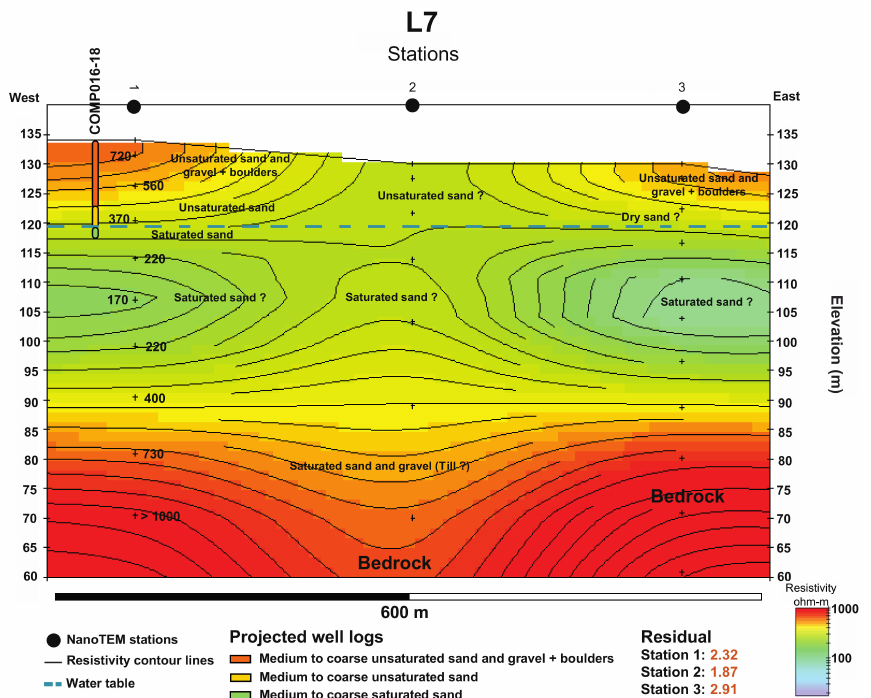
Figure 7. Interpreted 2D Section L7 near Saint-Stanislas, Quebec. Stratigraphic cross-sections YL016 and YL018 have been Scheme 016. The surface deposit elevation is obtained from lidar data. The blue dashed line represents the projected water table from direct observations in the field. The legend indicates only the sediments observed in situ. The deeper sedimentary facies are deduced from the empirical and petrophysical relationship (i.e., the calibration chart).